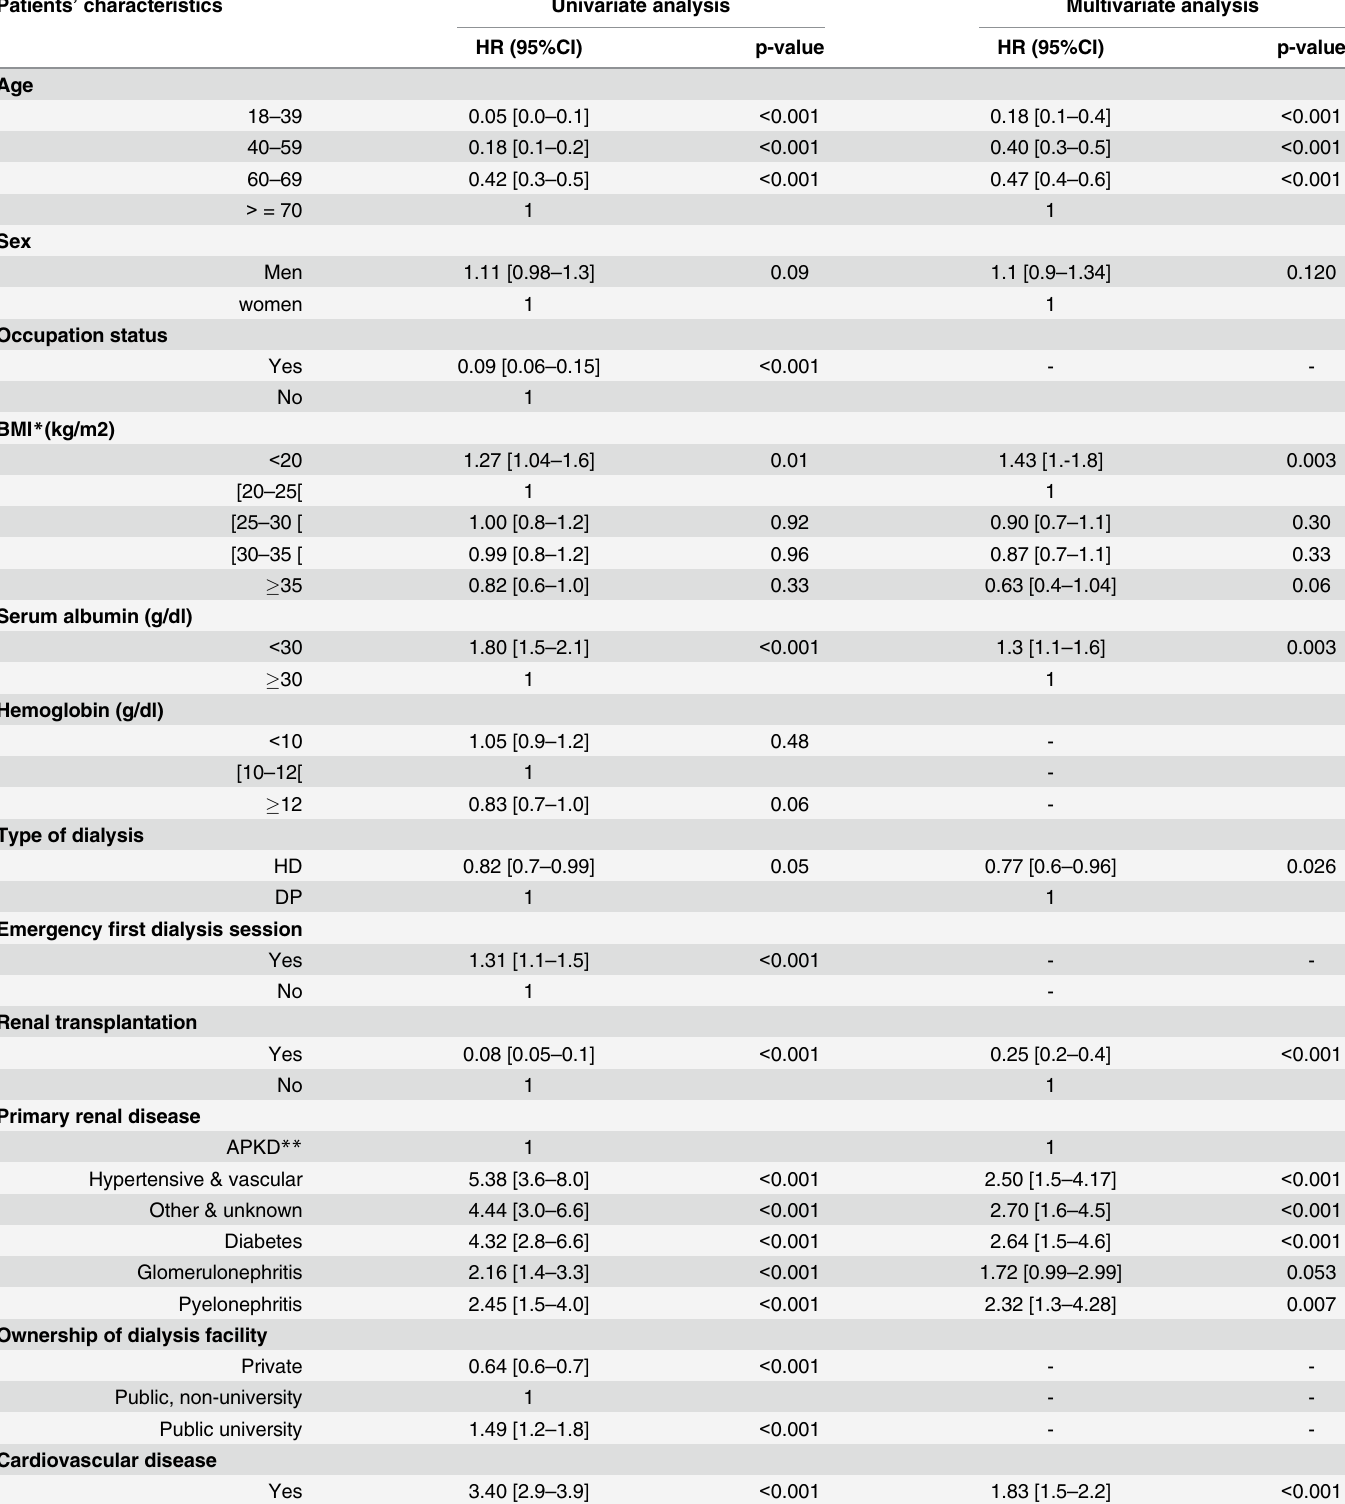
Table 3. Association between patients ’ characteristics at first dialysis and mortality (univariate and multivariate Cox